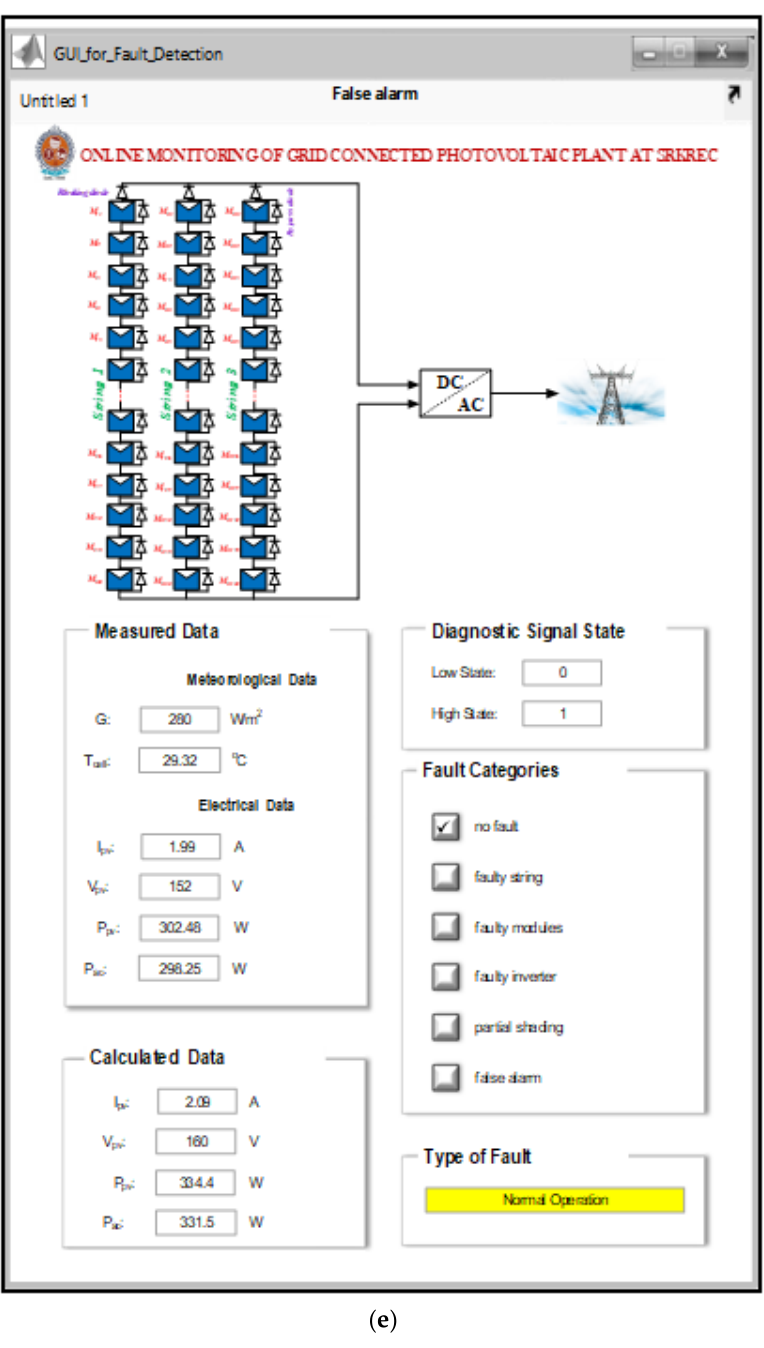
Figure 7. ( a ) Evolution of diagnostic signal during the no-fault condition; ( b ) false alarms were seen in the software that was designed; ( c ) measured PV current; ( d ) measured PV voltage; ( e ) fault-free operation observed in the designed tool.